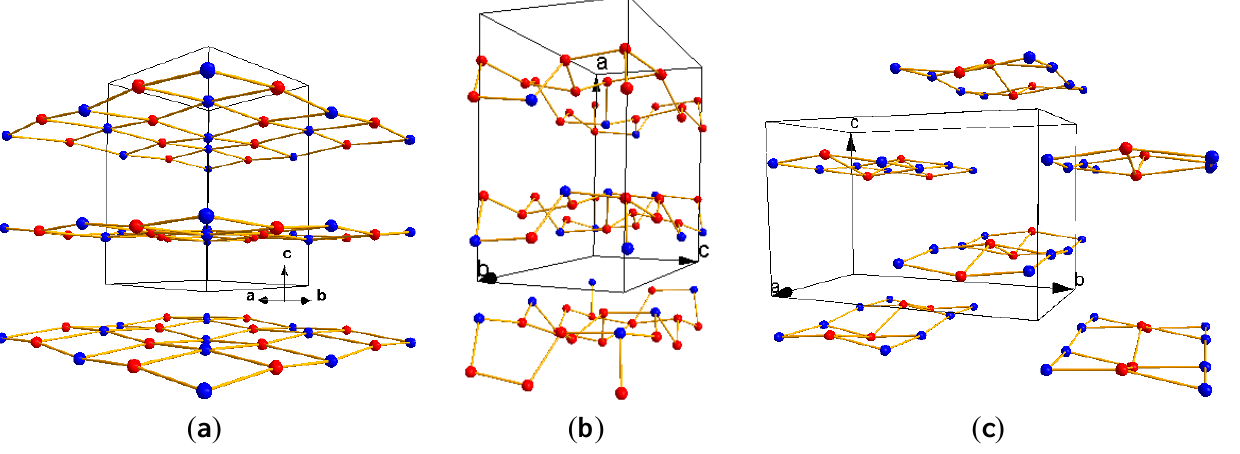
Figure 4. Schematic representation of water two-dimensional sub-network in ( a ) K; ( b ) L phases. Each sphere represents oxygen atoms in water molecules: the atoms in and ( c ) L 1 blue correspond to coordinated water molecules (note that the hydrogen atoms are omitted). The black lines delimit the unit cell in each structure and the arrows indicate the unit cell